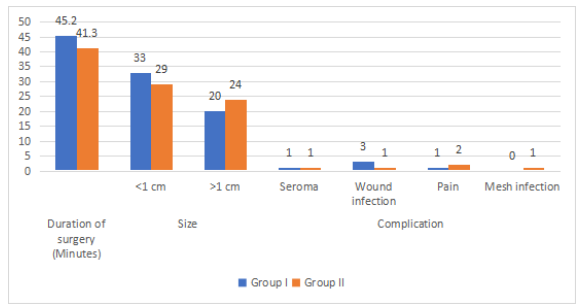
Figure 2. Graphically assessment of